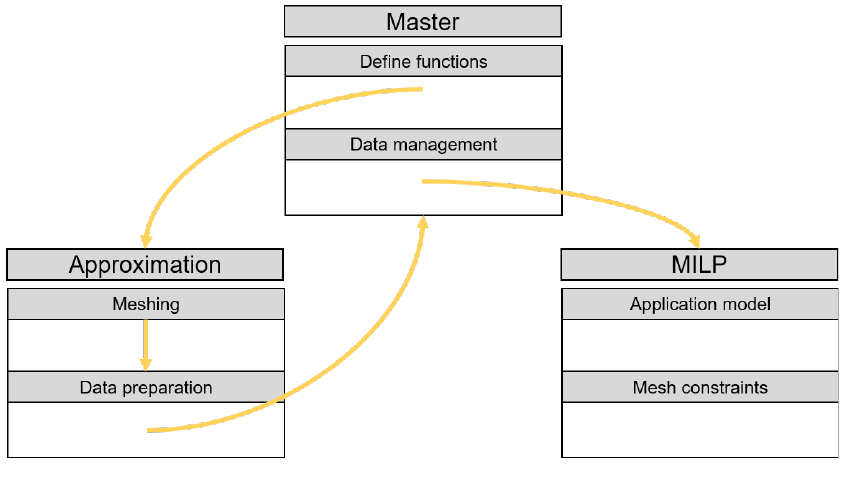
Figure 1. Architectonic design.